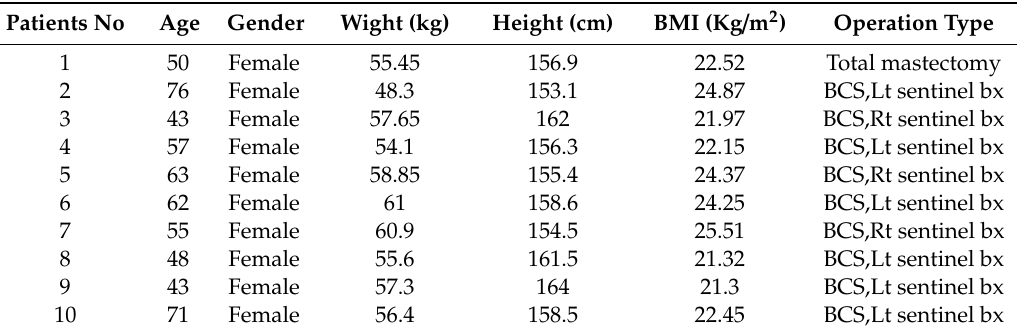
Table 1. Demographic features of patients.